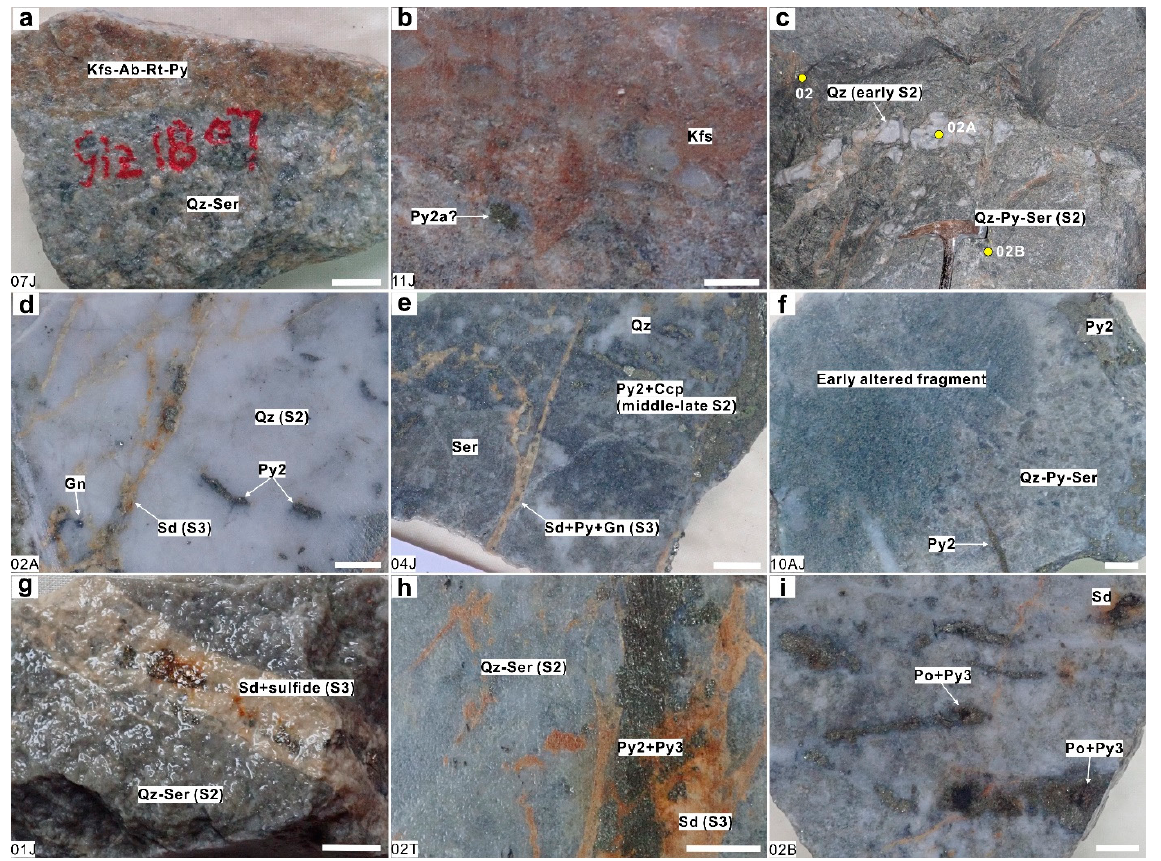
Figure 3. Photographs showing the occurrence of alteration and mineralization of the Sizhuang deposit. ( a ) and ( b ) K-feldspar-albite altered Linglong granite overprinted by early-phase sericitization and silicification. ( c ) Fractured white quartz vein cemented by intense quartz-sericite-pyrite alteration. ( d ) Pyrite aggregates mainly occurring as veinlet form in white quartz, which is crosscut by late siderite-pyrite vein. ( e ) Quartz-sericite-pyrite altered rocks exhibiting a breccia texture. ( f ) Early altered rocks replaced by late quartz-pyrite-sericite alteration showing a gradual relationship. ( g ) Quartz-sericite alteration crosscut by straight siderite-sulfide vein. ( h ) Fractured altered rocks and pyrite vein cemented by late siderite vein. ( i ) Pyrite vein locally replaced by late pyrrhotite and pyrite. Scale bar is 1 cm. Ab albite; Ccp chalcopyrite; Gn